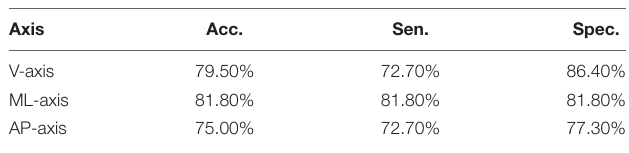
TABLE 3 | Classification results for LDA